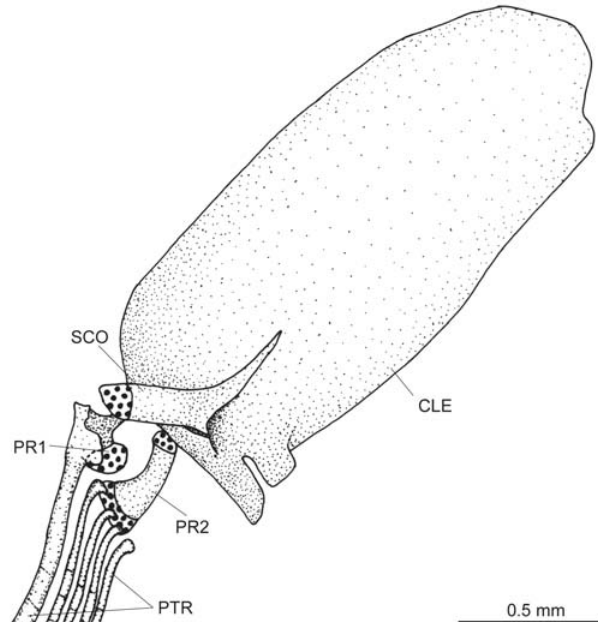
Fig. 7. Pectoral girdle of Ituglanis macunaima , paratype, LIRP 5642 (29.1 mm SL), ventral view of right side. Abbreviations: CLE, cleithrum; PTR, pectoral rays; PR1, proximal radial 1 (car- tilaginous); PR2, proximal radial 2; SCO,